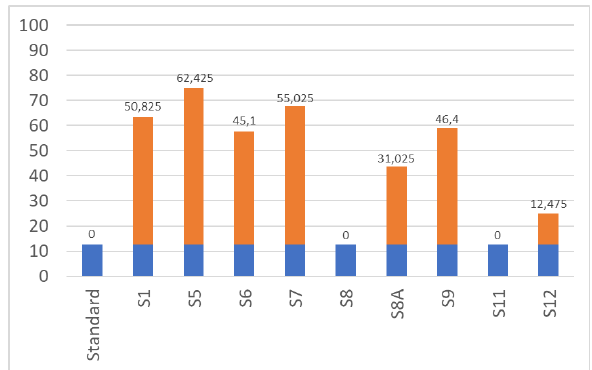
Figure 7 . Overall accuracies of the sole standard dataset, composed of S2-S3-S4 (blue-green-red, in blue bars), and the joint standard with other individual bands (in orange